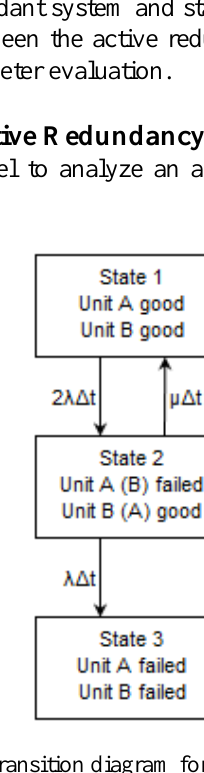
Fig. 3. State transition diagram for active